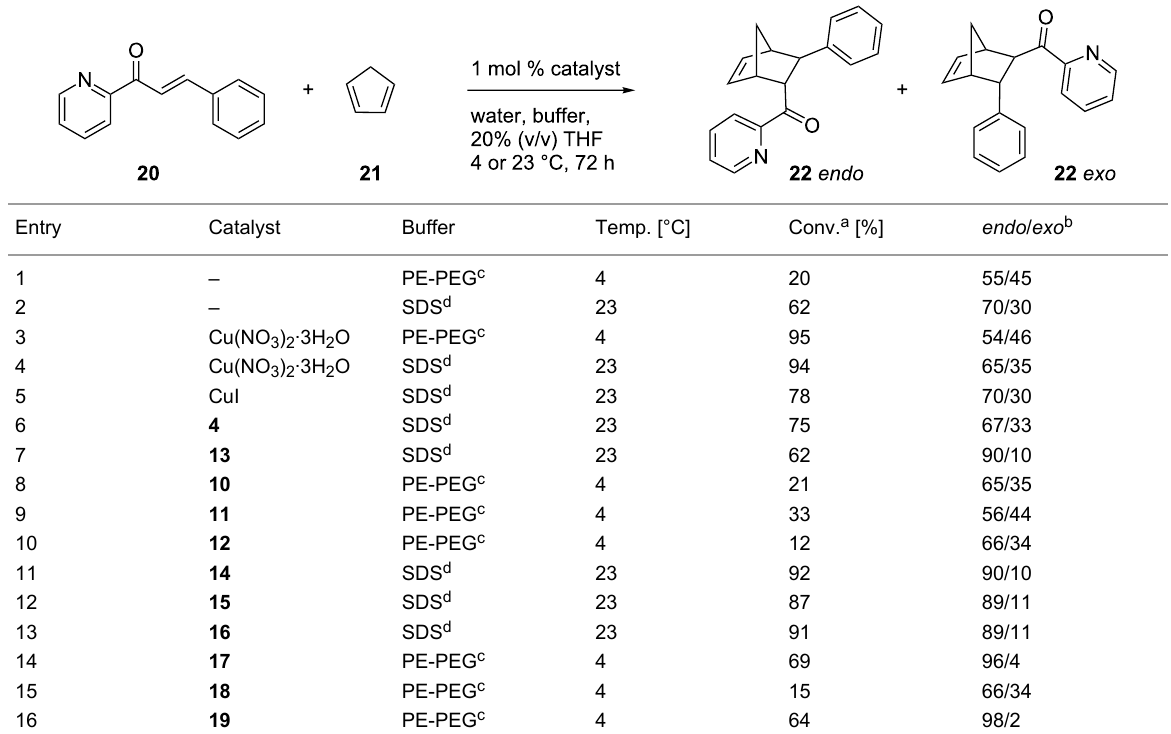
Table 1: Diels–Alder reaction catalyzed by the biohybrid catalysts.